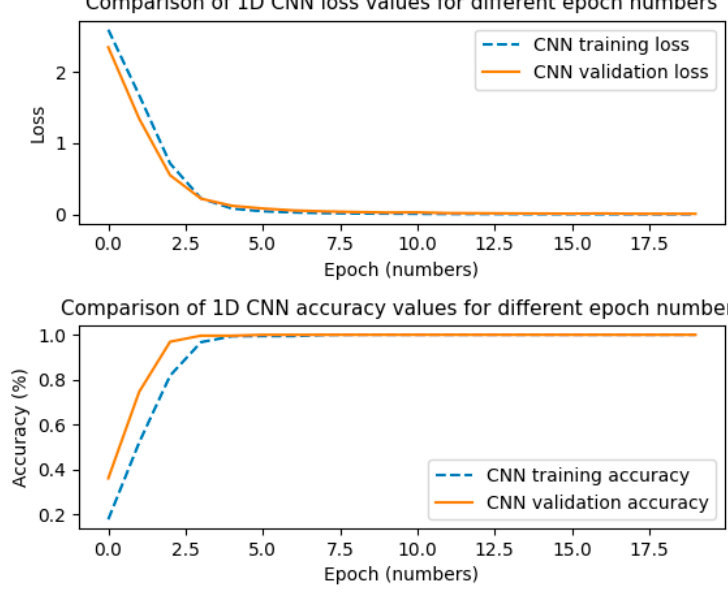
Figure 9. Loss and accuracy performance of 1D CNN model.